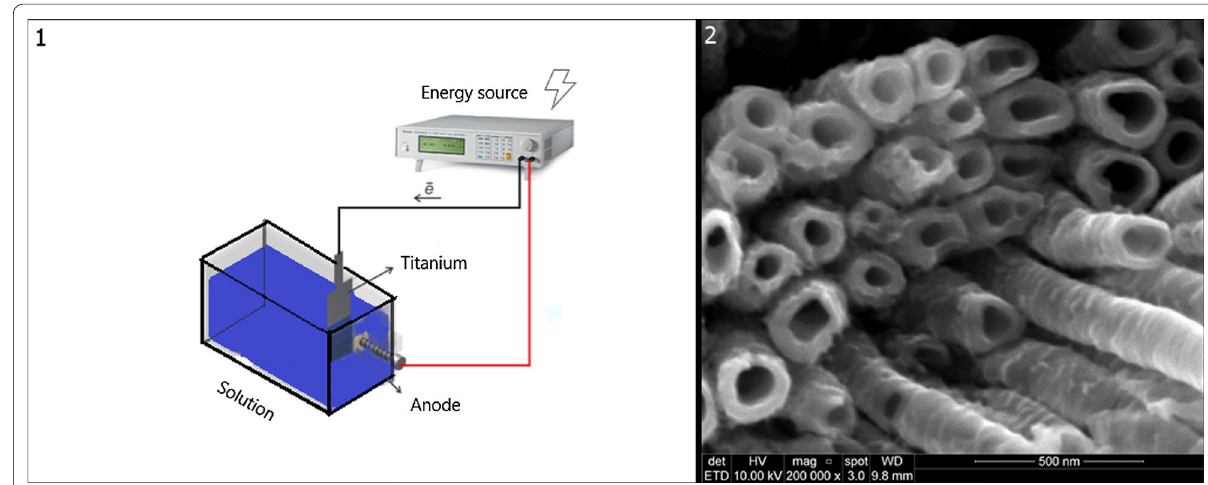
Fig. 1 Anodization process explanatory scheme ( 1 ). TiO 2 nanotubes made through anodization ( 2